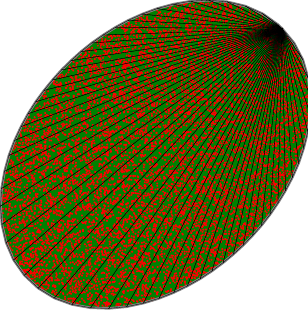
Figure 3. The result of random uniform sampling in the ellipse.